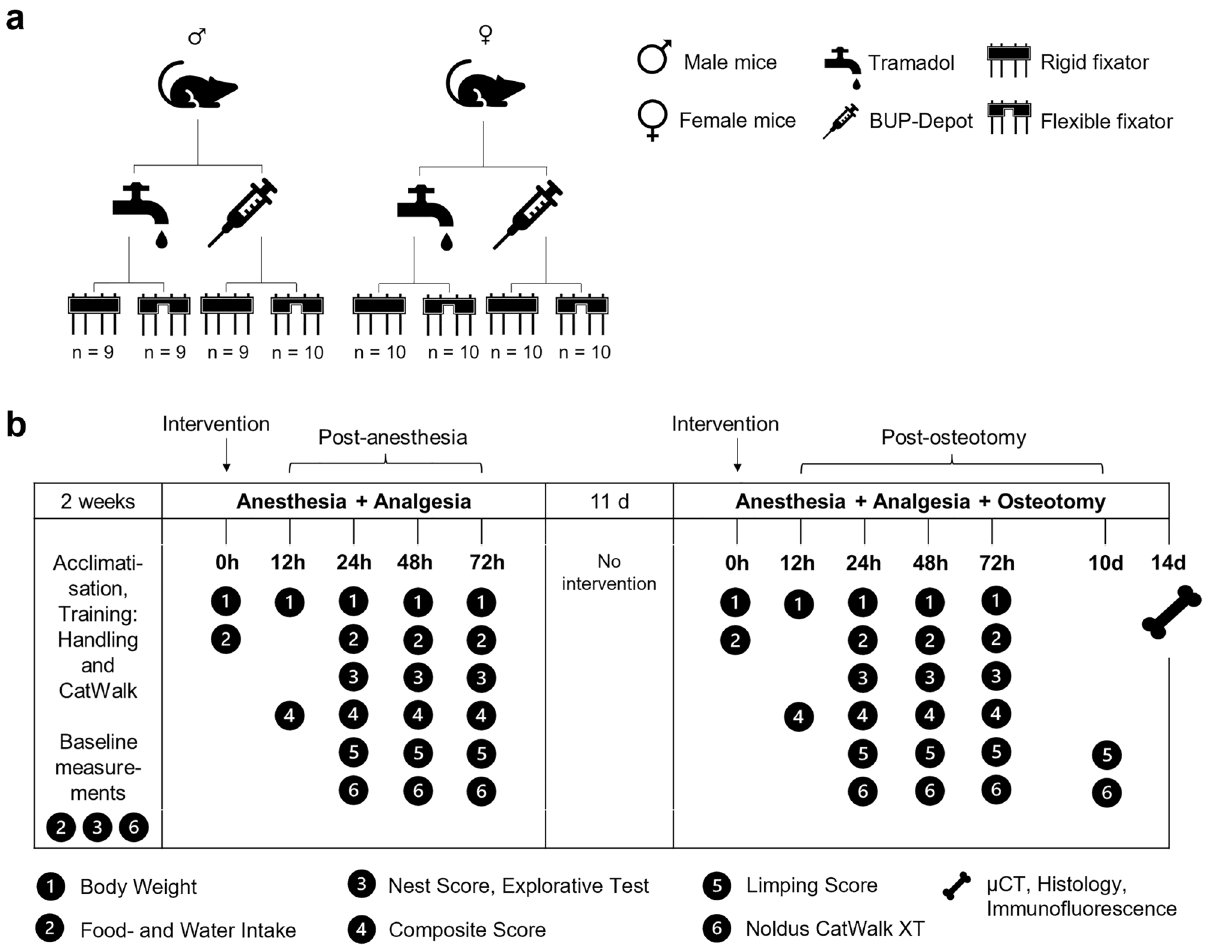
Figure 1. Group assignment and study design. Overview on ( a ) the group assignment, and ( b ) time points and measurements of the different parameters. To assure analgesic coverage during surgery, each animal received a single s.c. dose of Temgesic (1 mg/kg) at the beginning of each intervention. Depending on the assigned analgesic protocol, mice additionally received Tramadol (0.1 mg/ml) via the drinking water (provided one day before and for three consecutive days after the interventions) or a single dose of sustained-release BUP-Depot (1.2 mg/kg s.c) was administered at the end of the two Food and water intake per cage were assessed at 24 h, 48 h and 72 h post-anesthesia and post-osteotomy. Ini- tial values at 0 h covering the previous 24 h per cage were as follows: post-anesthesia—males 8.1 ± 0.7 g (food) and 9.2 ± 1.5 ml (water); females 7.8 ± 1.2 g (food) and 9.2 ± 1.2 ml (water); post-osteotomy—males 8.7 ± 1.0 g (food) and 9.9 ± 1.5 ml (water); females 8.4 ± 0.9 g (food) and 9.5 ± 0.9 ml (water). The lowest food and water intake (approximately 50% reduction to initial values) across all groups and sexes was measured 24 h after each inter- vention and reached the level of the initial values at 48 h (post-anesthesia) or 72 h (post-osteotomy) (Fig. 2c–f). No significant main effects were detected between treatment groups (Tables S2, S3). To rule out any constipating adverse effects of the BUP-Depot, all groups were closely monitored for defecation during the assessments, as constipation is a known-side effect of chronic-opioid usage 17,27 . However, a reduction in defecation was only noticeable at 12 h after both interventions but showed no differences between the Tramadol and BUP-Depot groups. The reduction in defecation was considerably more pronounced in female than in male mice (Fig. S2). Nest building and explorative behaviors are not influenced by the analgesic regime. To detect model independent changes in spontaneous behavior, monitoring of nest complexity scores and explorative behaviors was performed at 24 h, 48 h and 72 h post-anesthesia and post-osteotomy. Analyses showed no differ- ences in the nest building performance between the Tramadol and BUP-Depot groups post-anesthesia and post- osteotomy as medians ranged between scores of 4.5 to 5 (Fig. 3). Explorative behavior was present in all cages with male mice post-anesthesia while being reduced (no exploration) in some cages at 24 h post-osteotomy (8/20) independent of analgesic regime or fixation. In the female mice, 3 out of 20 cages (Tramadol flexible and BUP-Depot flexible) showed no explorative behavior at 24 h after both interventions (Fig. S3).